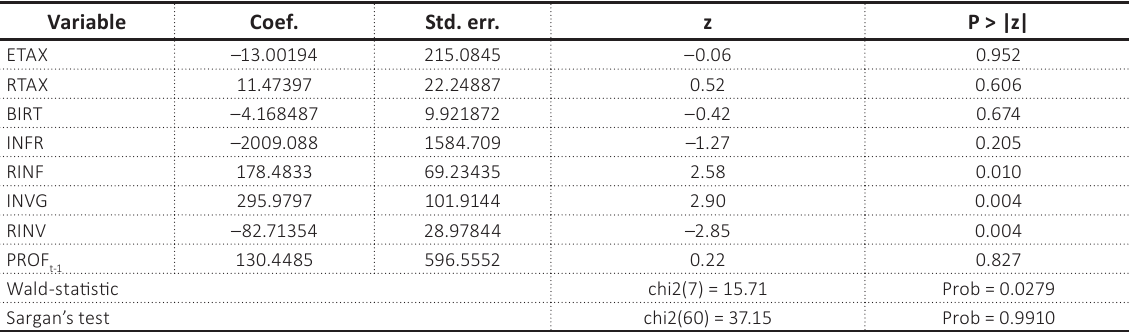
Table 5. Dynamic panel regression results of all sectors